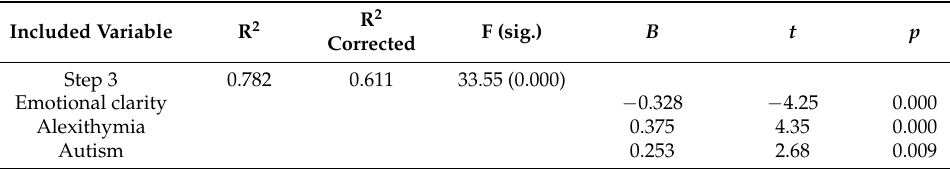
Table 4. Multiple stepwise linear regression coefficients for